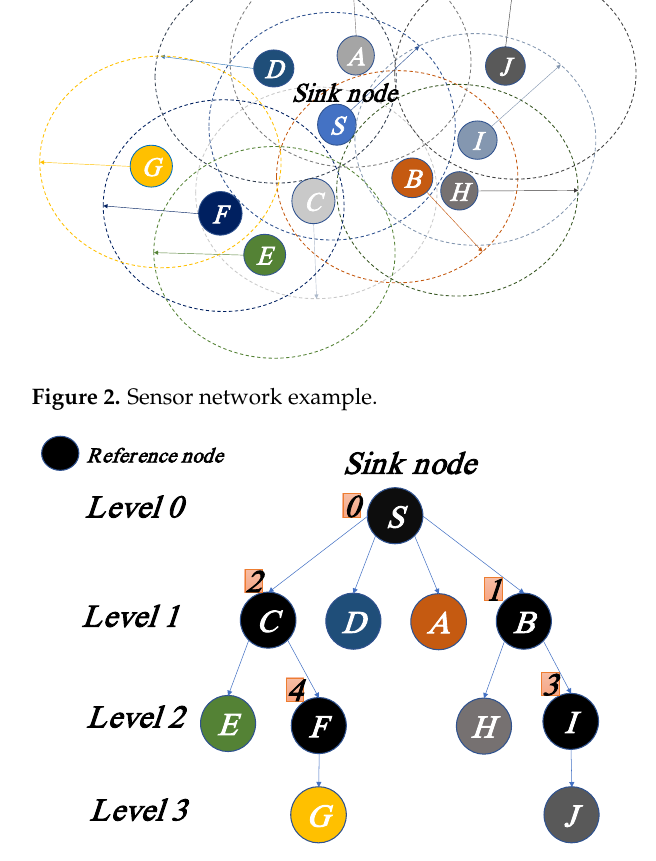
Figure 3. The tree created by the LPSRS scheduling process.